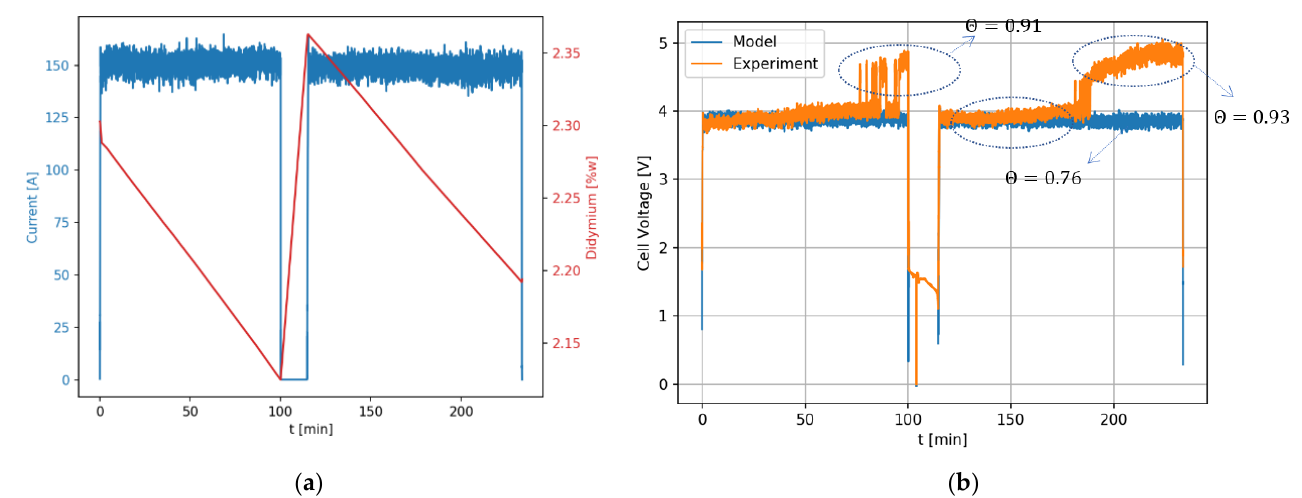
Figure 5. ( a ) Applied current and estimated oxide content evolution with time; ( b ) measured cell voltage compared to the model for stable operation.